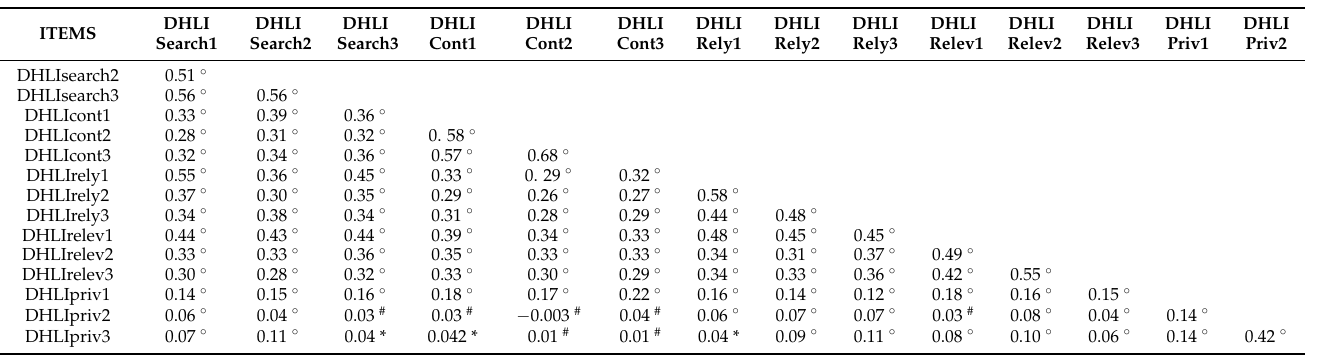
Table 2. COVID-19 Digital Health Literacy Instrument (DHLI): Spearman correlation analysis ( n = 3025).